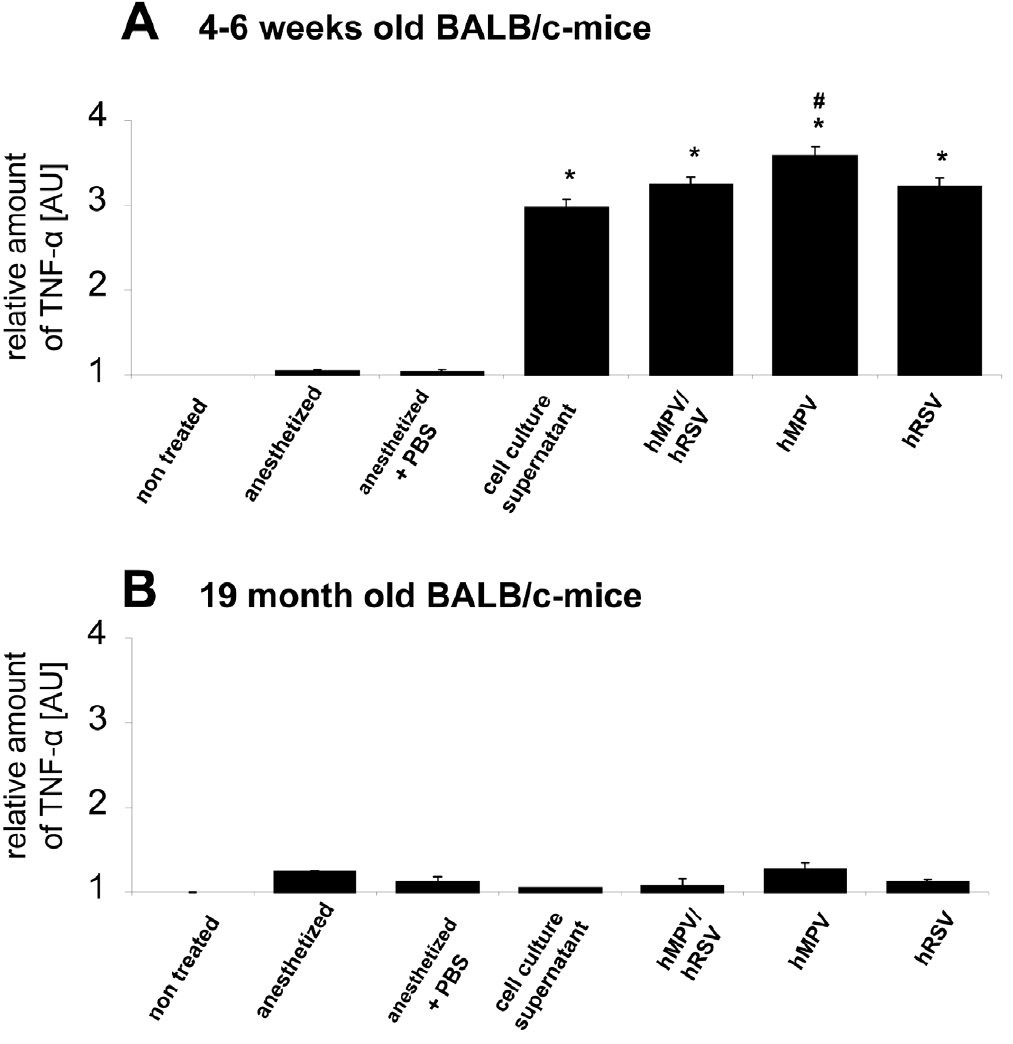
Figure 4. TNF- a expression in the lung after infection. Amount of TNF- a in the lungs of 4–6 weeks (A) und 19 months (B) old BALB/c mice after infection with RSV, HMPV or double infection: 4–6 weeks and 19 months old BALB/c mice were infected with 2 6 10 7 geq RSV or HMPV, or co-infected with 1 6 10 7 geq of each virus. Untreated animals, animals anesthetized and treated with cell culture supernatant or PBS or only anesthetized served as controls. Mice were killed by cervical dislocation and the lungs were removed and homogenised. The amount of TNF- a was determined by ELISA. Values were standardized referring to non treated controls (n=3–5, values are shown as mean 6 standard deviation). * significantly different to untreated animals (p , 0.05). # signifcantly different to cell culture infected animals (p , 0.05).